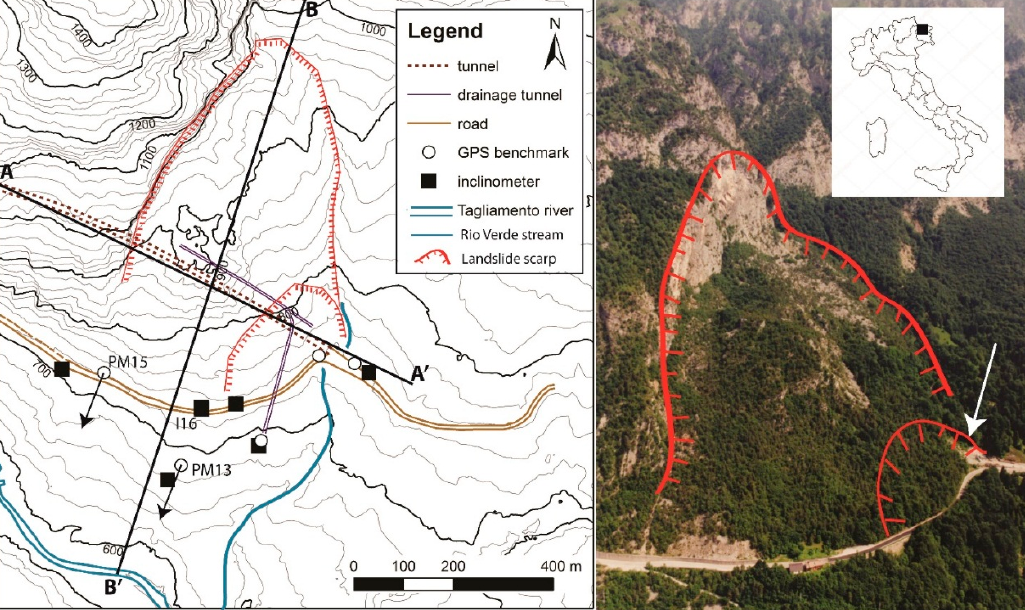
Figure 1. Study area with cross sections A − A’ and B − B’ for the geological model; in the photograph on the right the eastern entrance of the tunnel is indicated by a white arrow. GPS: Global Positioning System; PM: name of the GPS benchmark.